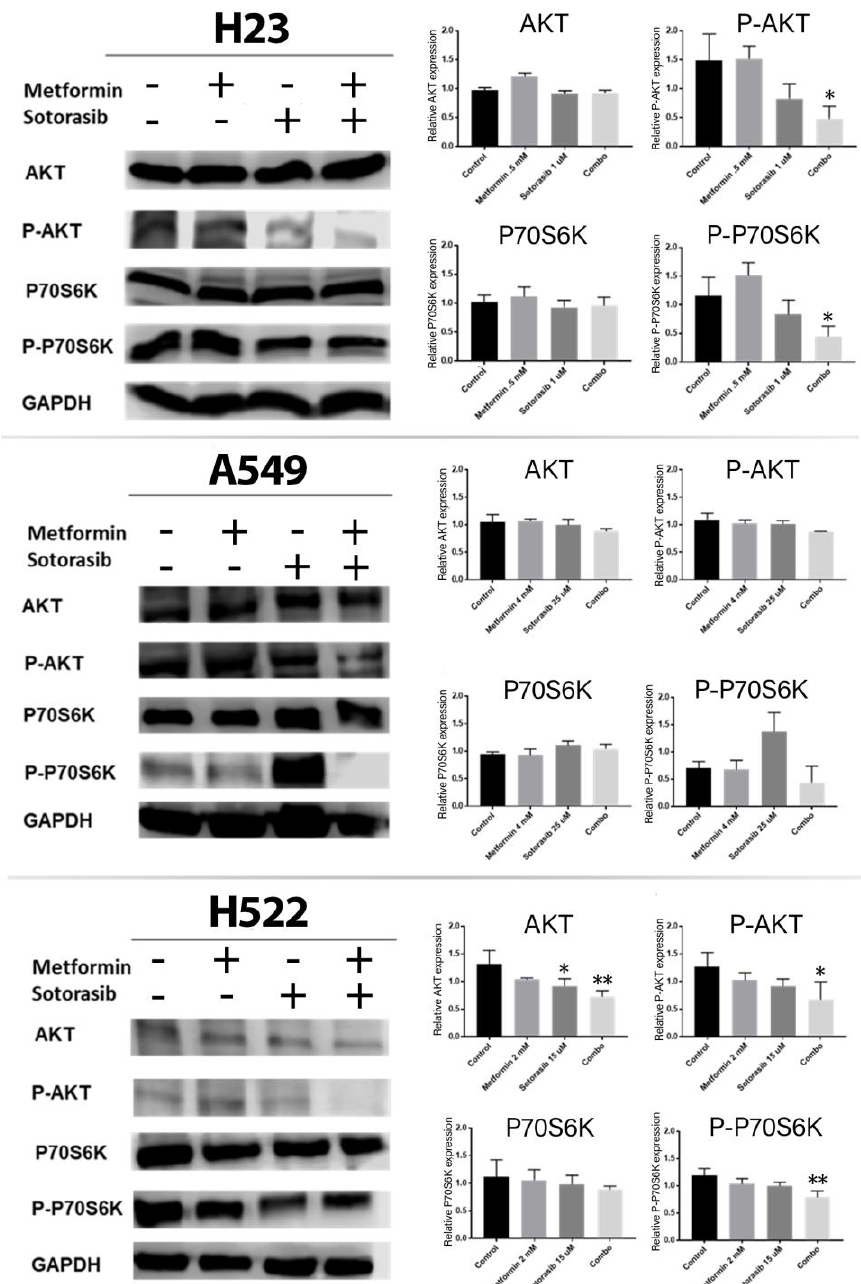
Figure 4. Effects of metformin and sotorasib on proteins involved in downstream signaling of growth factor receptors. Cells were seeded and treated for 72 h with their respective therapy. Then, protein was extracted and analyzed by Western blot using GAPDH as endogenous control. After this, resulting Western blot images were analyzed by ImageJ software version 1.54 (NIH) to quantify the intensity of each band. Subsequently, means of three independent experiments were represented as a single bar for each protein in the above graphics, created by GraphPad Prism software version 8.0.1 (Dotmatics, Boston, Massachusetts, USA). Data were normalized regarding GAPDH, and they were statistically analyzed using one-way ANOVA. Significant differences are represented as * p ≤ 0.05, ** p ≤